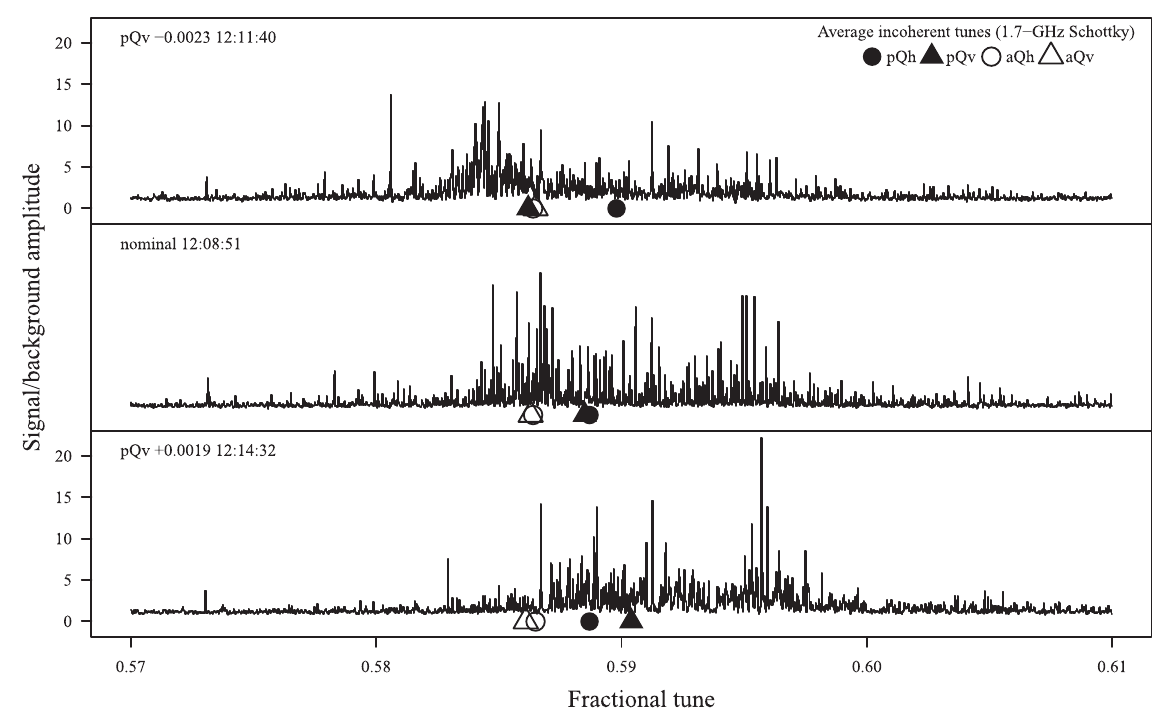
FIG. 11. Response of vertical coherent modes for proton bunch P11 to lattice tune changes during Store 7711. −88.0−87.5−87.0−86.5−86.0−85.5